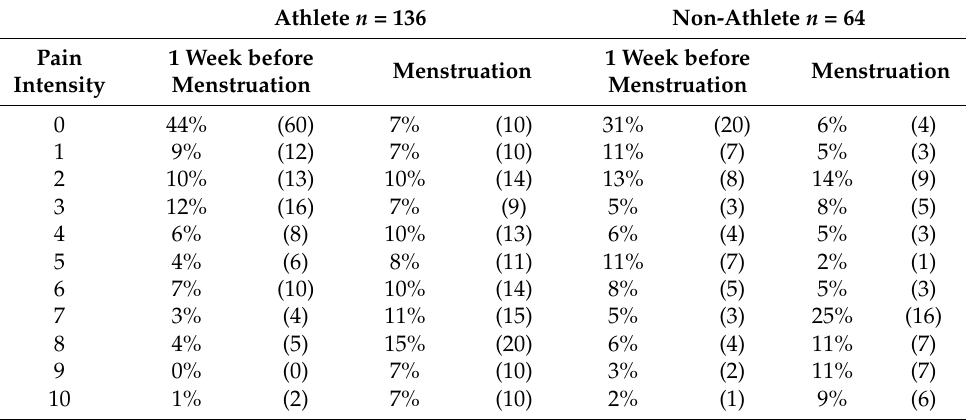
Table 5. Pain intensity one week before menstruation and during menstruation in athletes and